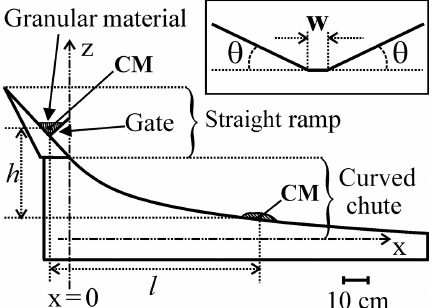
Figure 1. Longitudinal cross section of all the channels used in the numerical simulations. The inset illustrates the transversal cross section of both the straight ramps and the curved chutes where quan- tities w (the channel width) and θ (the sidewall inclination) are shown. CM stands for center of mass.